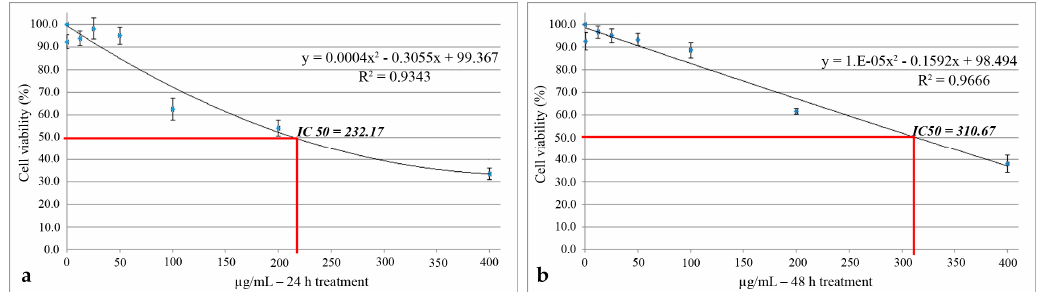
Figure 5. IC 50 values after 24 h ( a ) and 48 h of ( b ) UBE treatment on CAL 27 cells.